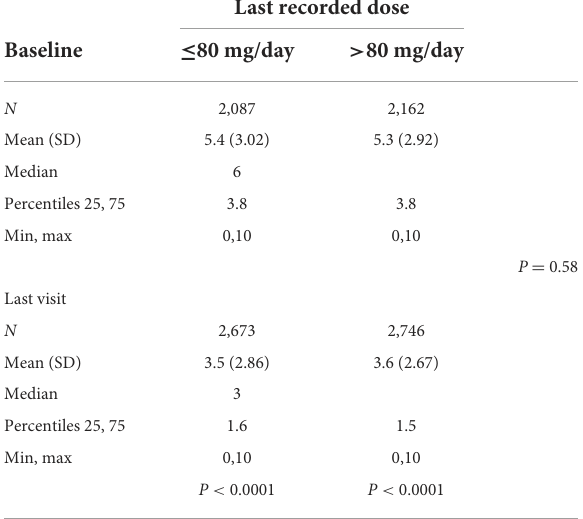
TABLE 4A Alcohol craving for the overall population – last recorded dose.